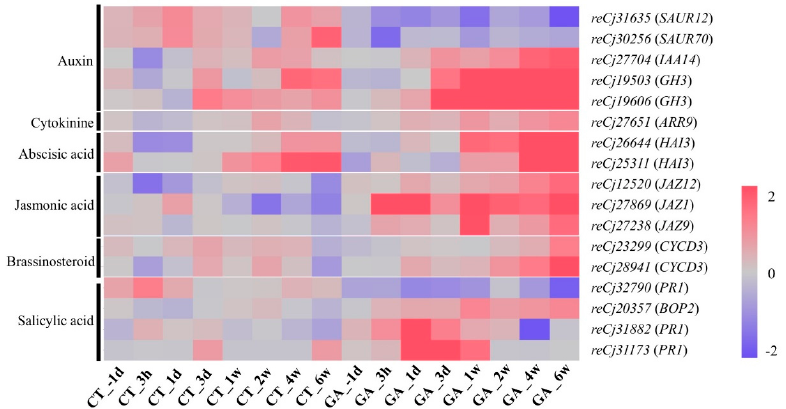
Figure 5. The heat map analysis associated with plant hormone signal transduction pathways without GA. The relative expression values were log 2 transformed. Red indicates high expression; blue indicates low expression. CT_ − 1 d, CT_3 h, CT_1 d, CT_3 d, CT_1 w, CT_2 w, CT_4 w, CT_6 w, GA_ − 1 d, GA_3 h, GA_1 d, GA_3 d, GA_1 w, GA_2 w, GA_4 w, and GA_6 w are sample names. Details of these genes are provided in Table 1.